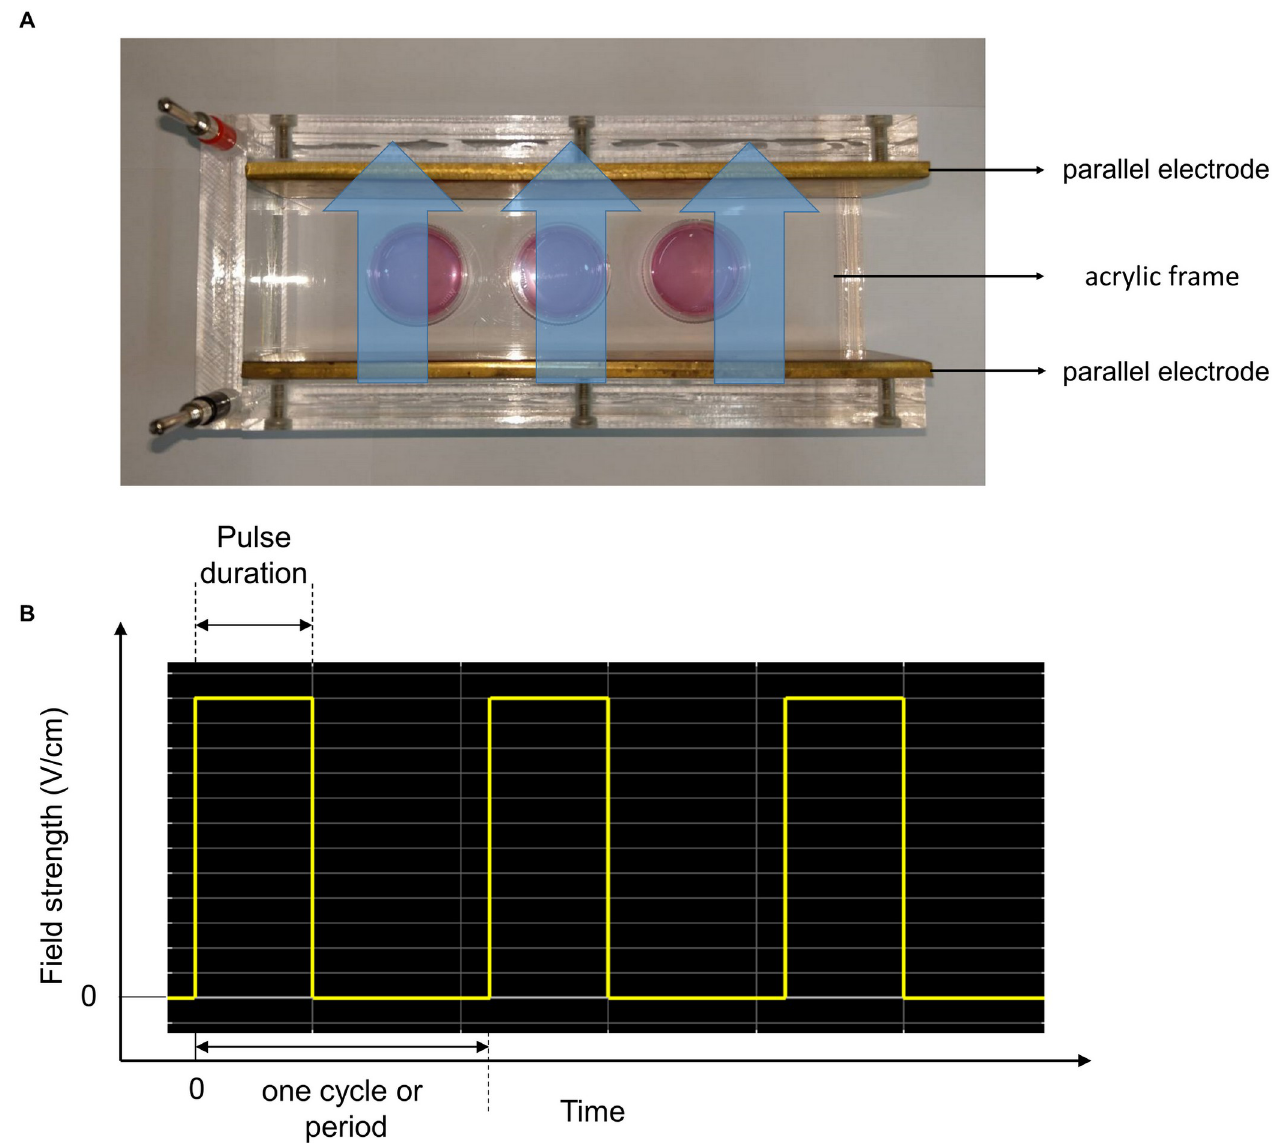
Fig 1. The experimental setup of H-LIPEF. (A) Image of the H-LIPEF stimulation device. The culture dishes were placed in the stimulation device constructed of two parallel electrodes. The blue arrows shown here indicate the schematic representation of non-invasive H-LIPEF exposure on cells. (B) Schematic representation of the pulse train waveform applied on the electrodes.